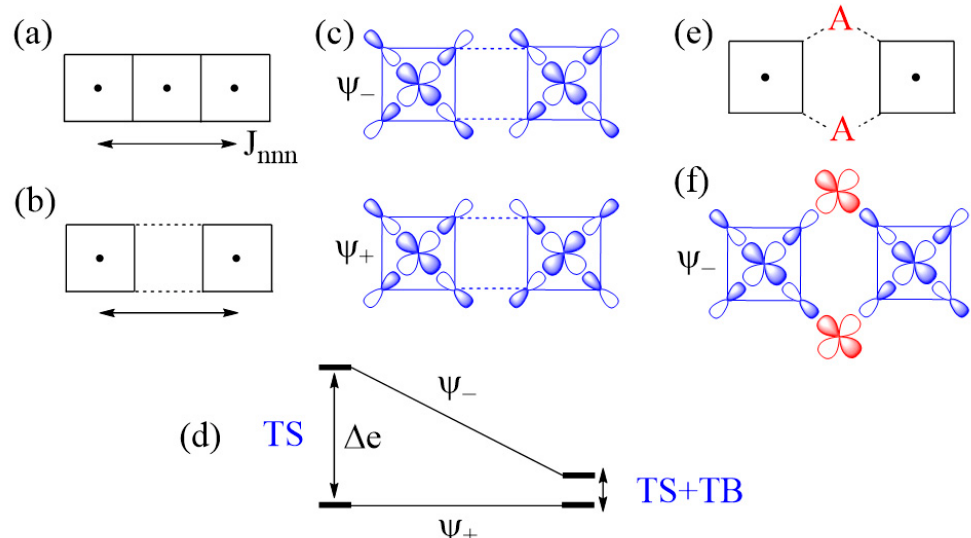
Figure 7. ( a ) The next-nearest-neighbor spin exchange J nnn in a CuL 2 ribbon chain made up of edge-sharing CuL 4 square planes. ( b ) A case of strong Cu–L . . . L–Cu exchange, which represents the next-nearest-neighbor exchange J nnn . ( c ) The in-phase and out-of-phase combinations of the two magnetic orbitals, Ψ + and Ψ − , respectively, associated with the Cu – L…L – Cu exchange. ( d ) The large energy split Δ e resulting from the through-space (TS) interaction in the Cu – L…L – Cu exchange becomes small in the Cu – L…A…L – Cu exchange as a result of the through-bond (TB) ψ interaction that occurs with the − state. ( e ) A Cu – L…A…L – Cu exchange generated when each ψ L…L contact is bridged by a d 0 metal cation A. ( f ) The bonding interaction of the − state with the d π orbital of A.